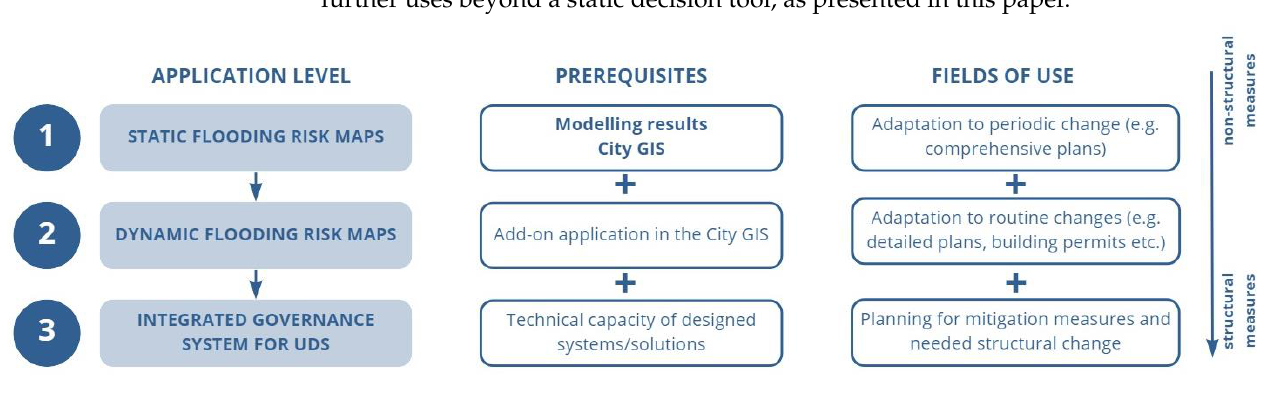
Figure 10. Application potential of EWL to both structural and non-structural measures.